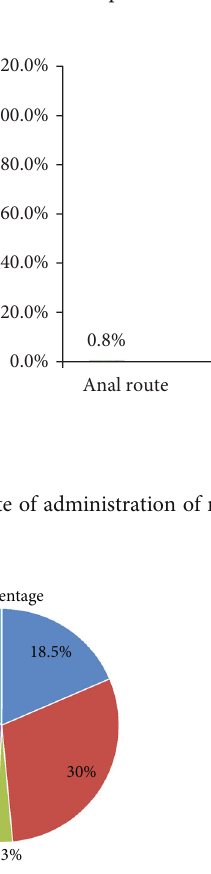
Figure 6: Plant parts used for the treatment of intestinal parasitosis in Ethiopia.